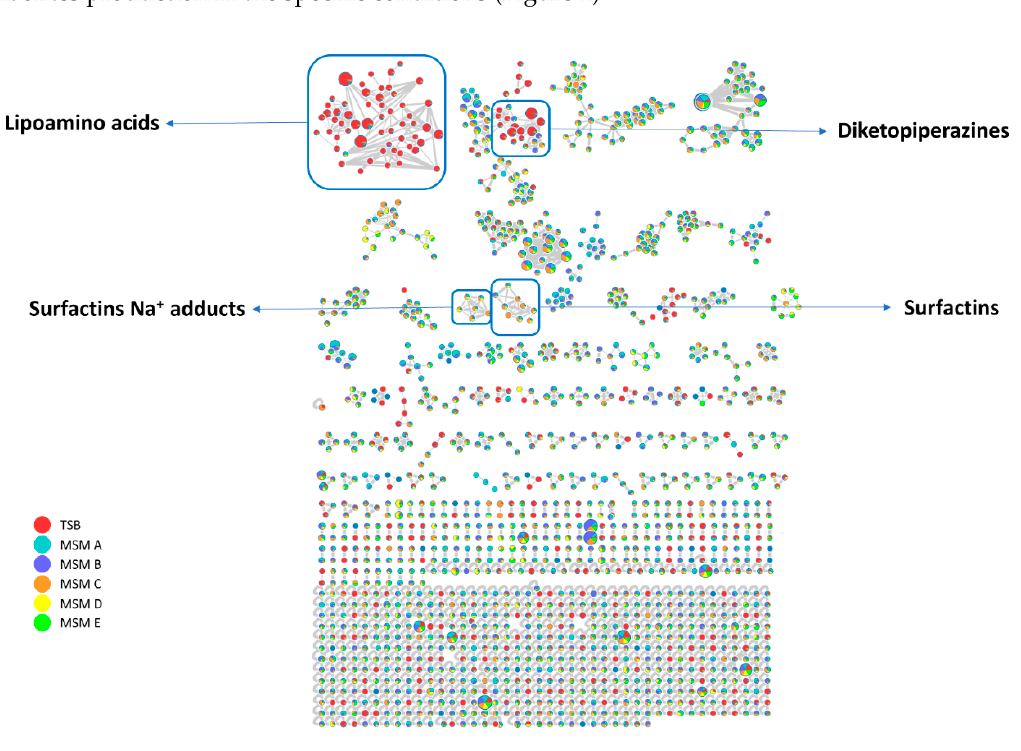
Figure 2. Pantoea cf. eucrina D2 metabolic network overview, it was obtained through global natural products social molecular networking (GNPS) and Cytoscape. The presence of lipoamino acids, diketopiperazines and surfactins clusters are displayed.